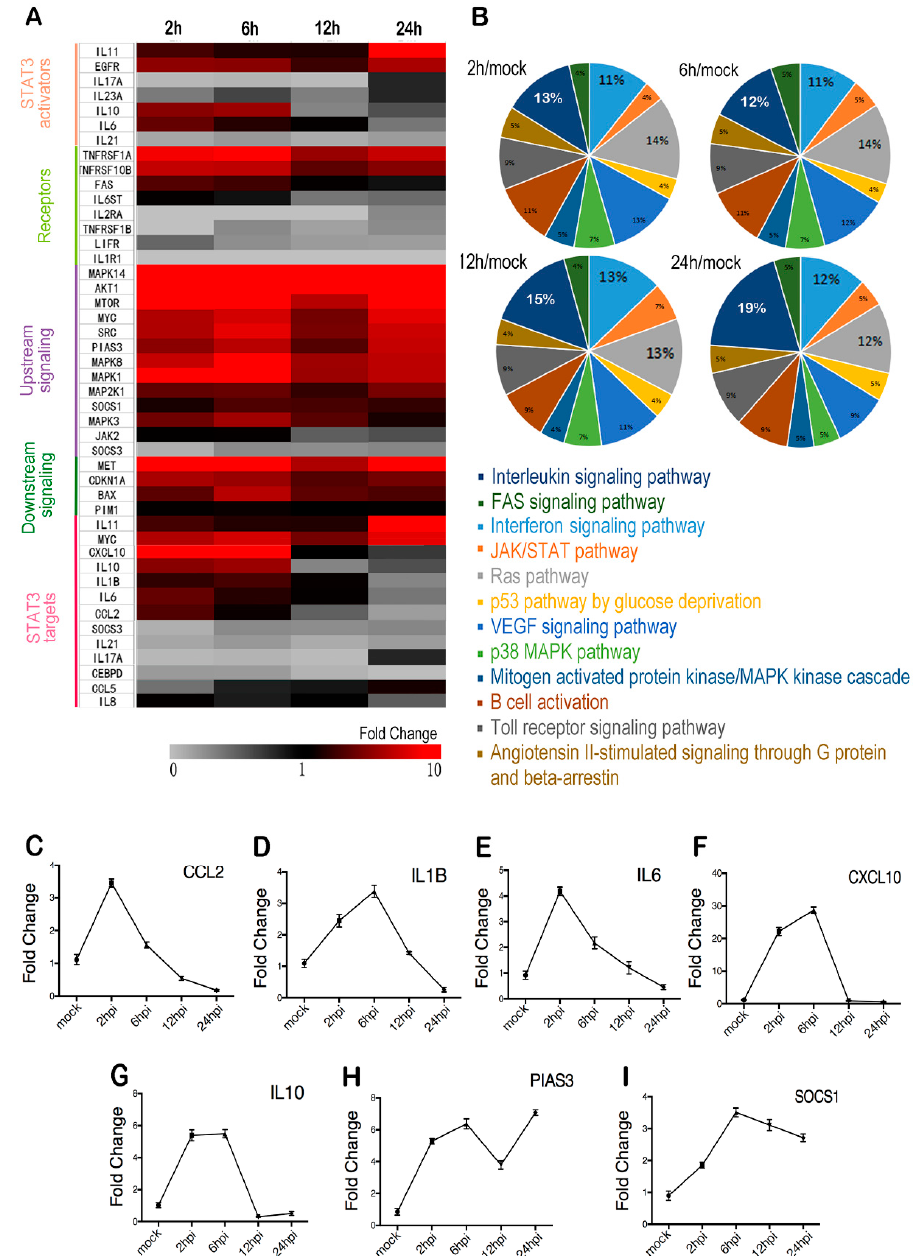
Figure 2. STAT3 signaling-related gene expression during EV71 infection. Total RNA of EV71 infected T98G cells was extracted at indicated time points. After reverse-transcription, the cDNA was subjected to RT2 Profiler PCR Array analysis. ( A ) Relative transcription levels of STAT3-related genes during infection were presented by fold changes in a heat map. In the RT2 Profiler PCR Array, IL-10 and IL-6 were considered to be both activator and targets of STAT3 as shown in the heatmap. ( B ) Di ff erentially expressed genes from each group (log 2 fold change > 2 or < − 2, adjusted p < 0.05) were subjected to GO Enrichment Analysis and the percentages are shown in pie charts. ( C – G ) Fold changes of verified STAT3 targets at indicated time points post infection. ( H – I ) Fold changes of STAT3 regulators at indicated time points post